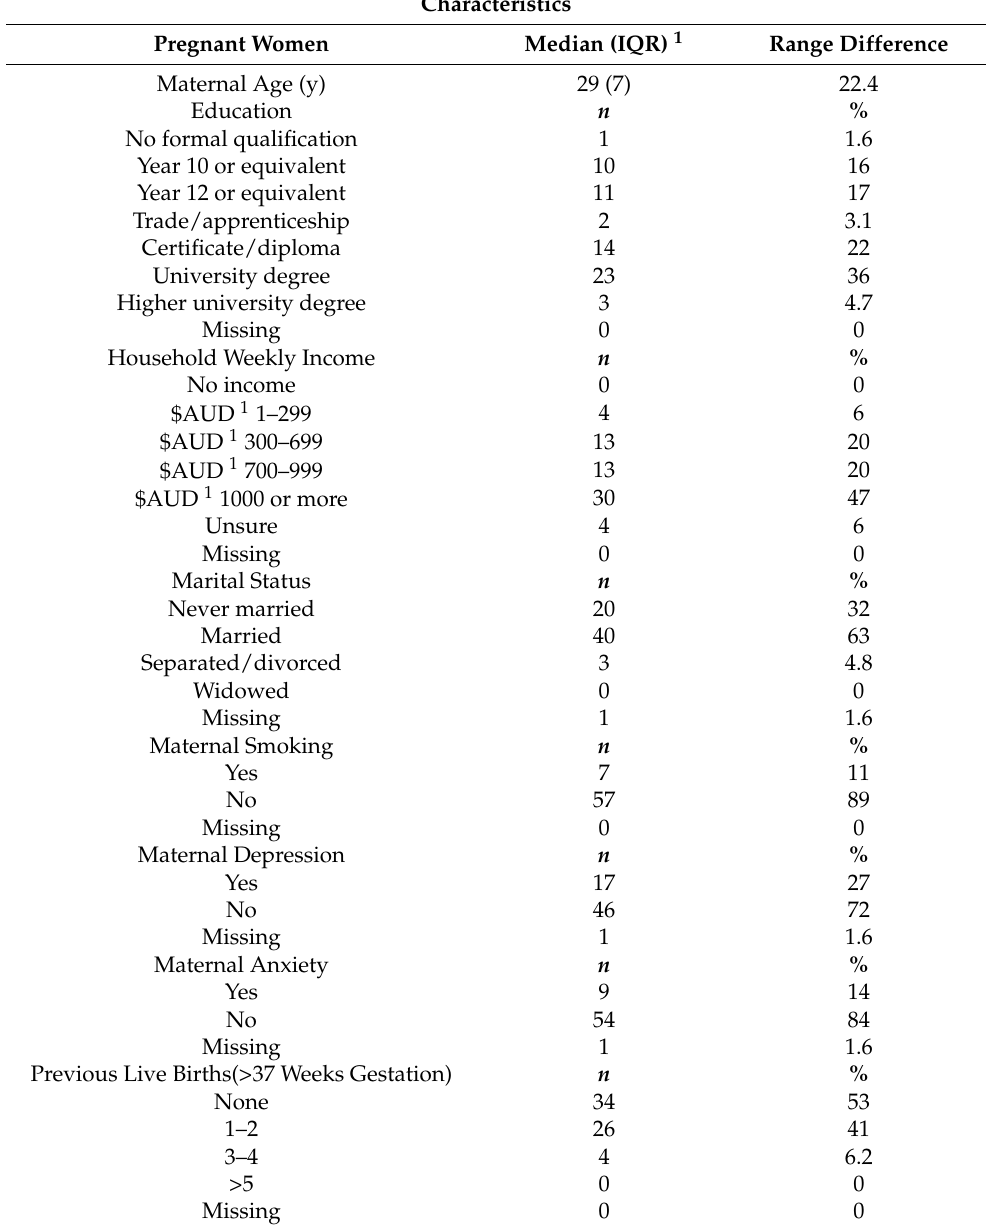
Table 1. Characteristics of the WATCH mother–child dyads included in the analysis ( n =